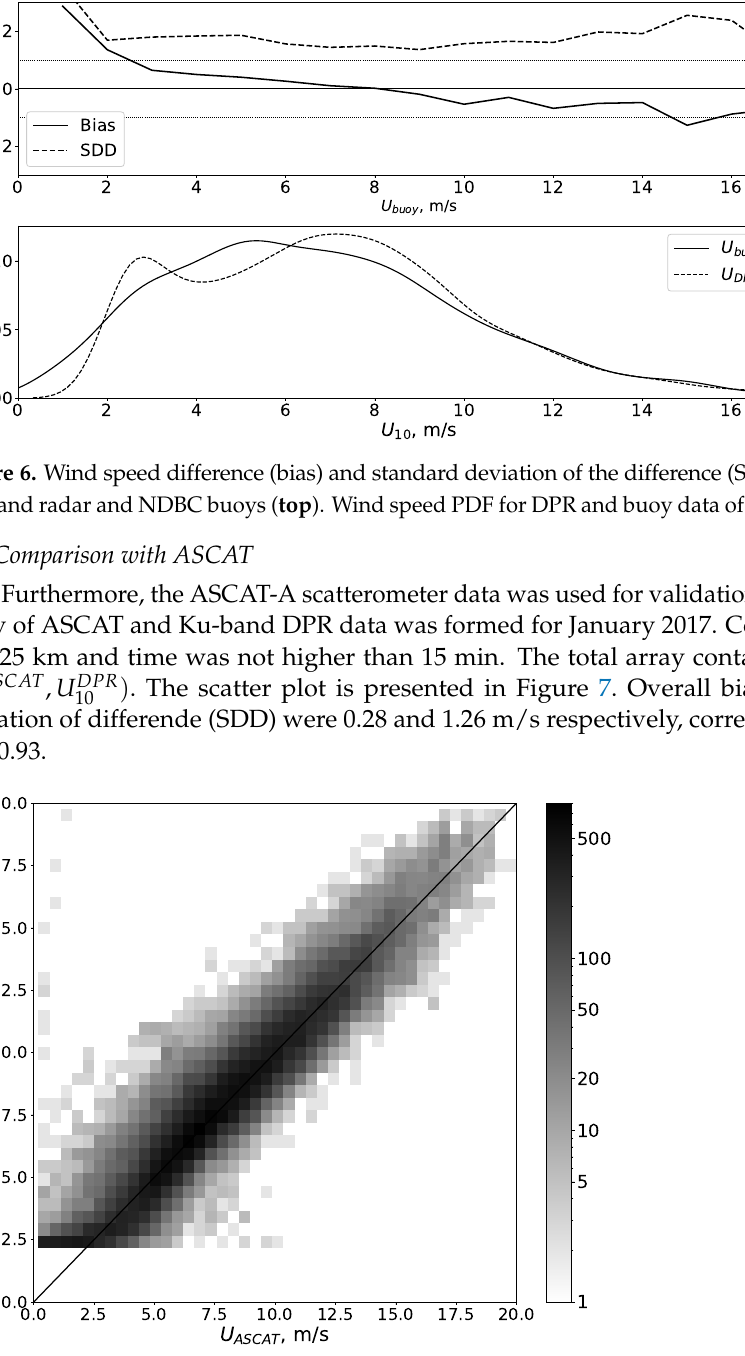
Figure 7. Global comparison between Ku-band radar and ASCAT wind speed values during Jan- uary